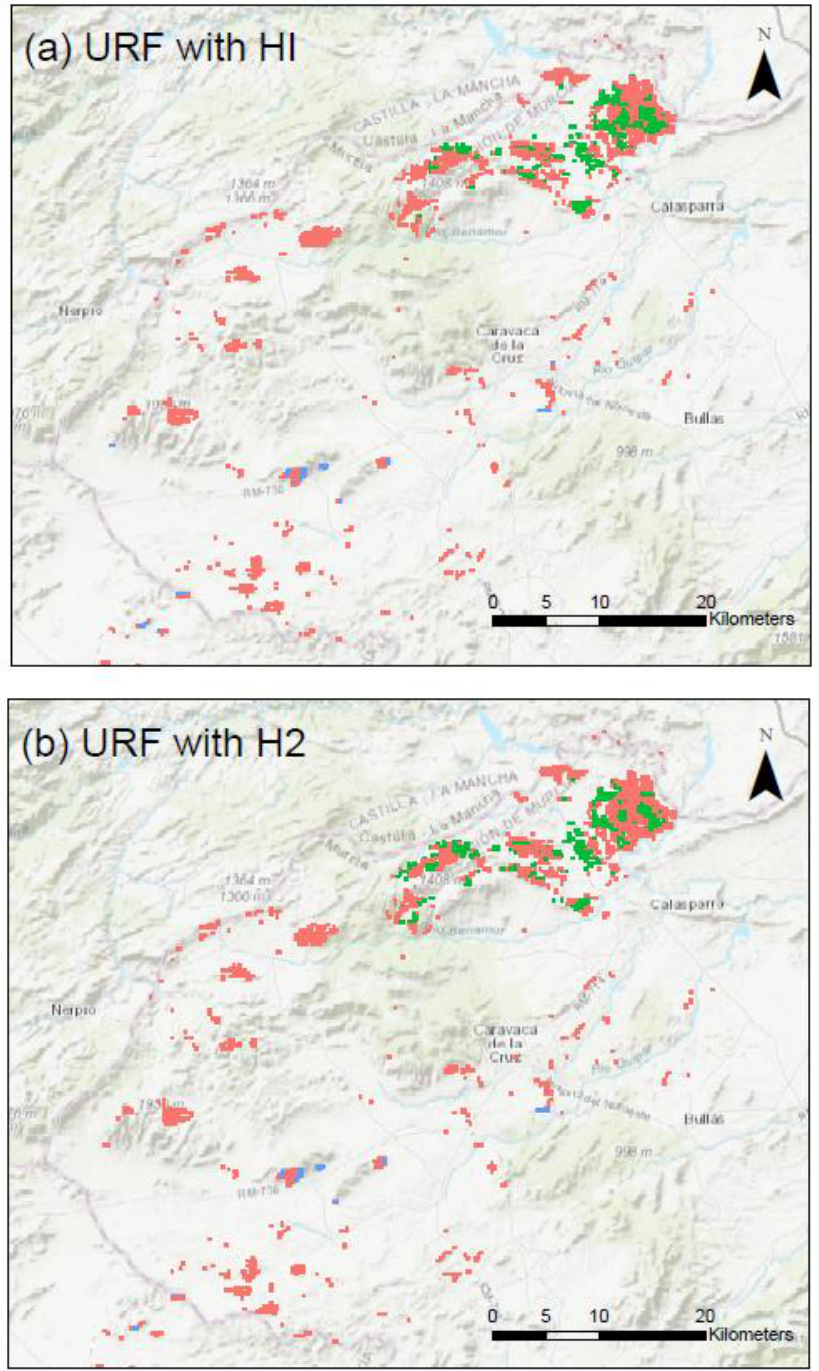
Figure A5. Comparison of the clustering results for URF using HI ( a ) and H2 ( b ) in the agricultural region of Murcia-NW. Cluster 1 is pink, cluster 2 is green, and cluster 3 is blue.